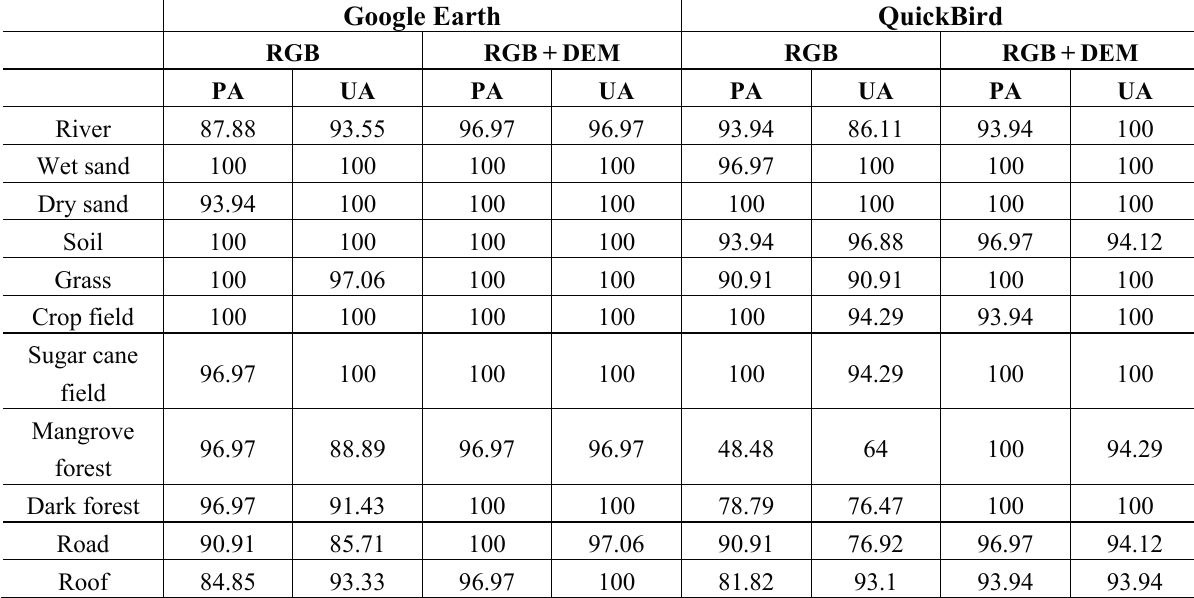
Table 4. Producer’s accuracy (PA) and user’s accuracy (UA) of the 11 land cover types with respect to the RGB Google Earth-derived very high resolution mosaic, QuickBird pansharpened datasets, and digital elevation model